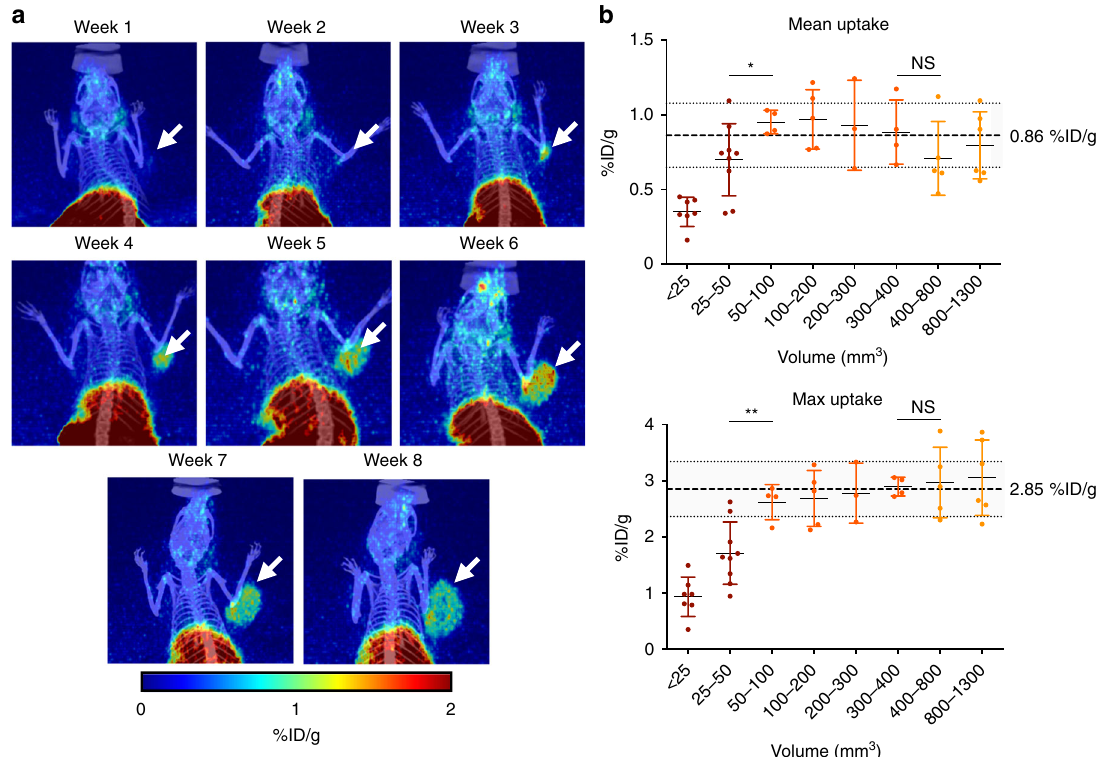
Fig. 5 Tumor size to [ 18 F]PARPi uptake correlation. JHU-LX48 SCLC PDX bearing mice ( n = 6) were injected (i.v.) with 200 – 300 µ Ci of [ 18 F]PARPi and imaged. PET/CT imaging was performed once a week over 8 consecutive weeks starting one week after xenografting. a Representative MIPs from the same mouse over 8 weeks. b Quanti fi cation ( n = 6) of mean uptake (top) and max uptake (bottom) of the PET images grouped by tumor size. Mean uptake was calculated to be 0.86 %ID/g across a large range, from 50 – 1300 mm 3 , of tumor sizes as quanti fi ed from CT VIOs. Small tumor sizes ( < 50 mm 3 ) are likely affected by partial volume effect 19 . The fi gure includes the standard deviation as indicated by the shaded area. Non-parametric Student ’ s t -test was used to calculate the statistics. * P < 0.05; ** P < 0.01. Error bars represent the